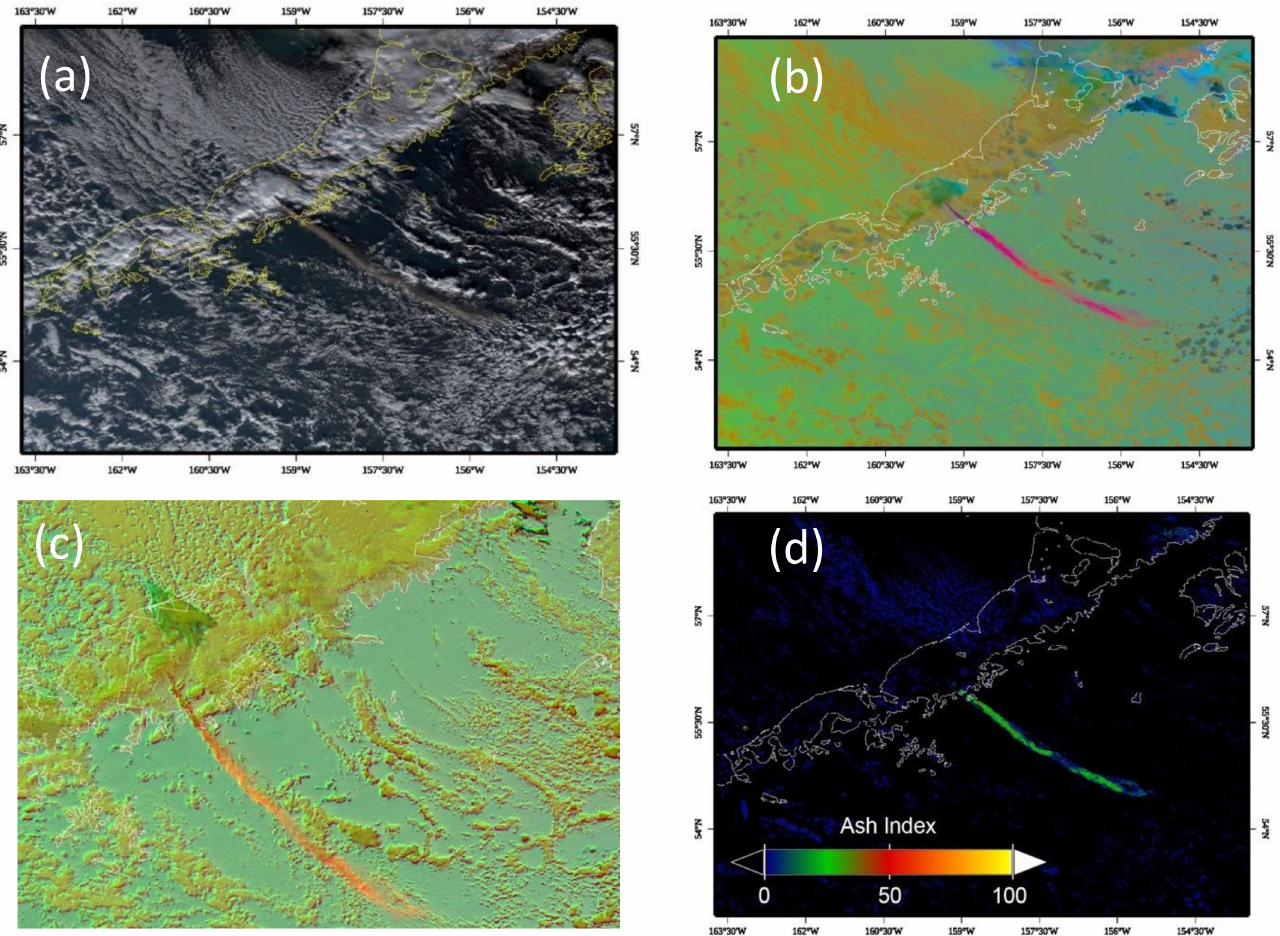
Figure 8. Ash plume from the 2018 Veniaminof eruption as seen by SNPP VIIRS at 22:30 UTC: ( a ) true color RGB composite, ( b ) false color composite of TIR, ( c ) operational (AWIPS) TIR false color RBG generated at A-VAAC, and ( d ) the VIIRS Ash Index from GINA/DRL VIIRS-SO 2 SPA (v1.3) similar to Figure